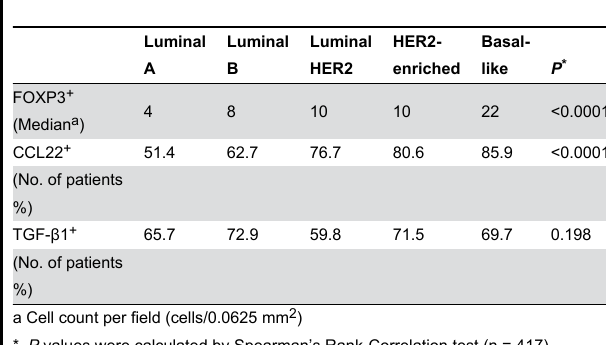
Table 2. Expression of CCL22,TGF-β1 and Foxp3 + Tregs among BC molecular